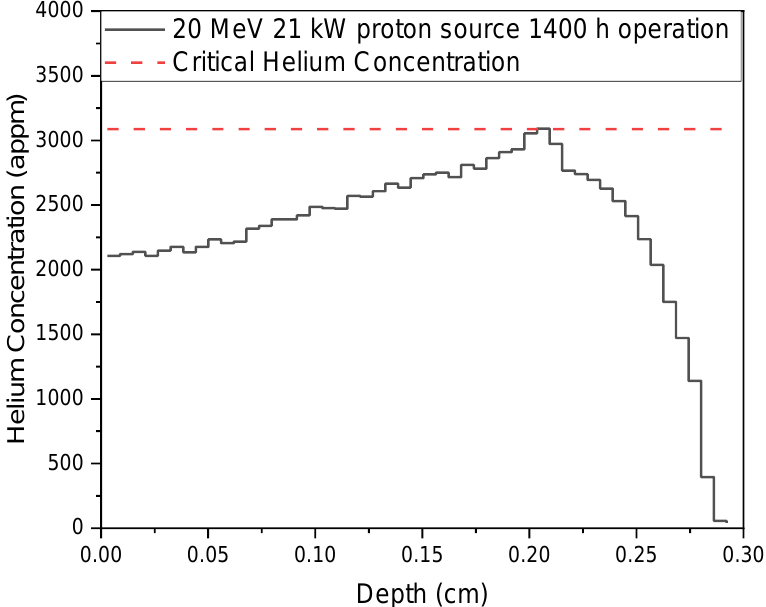
Figure 4. The concentration distribution of helium atoms generated by the 20 MeV/21 kW proton source after a 1400-h-operation.